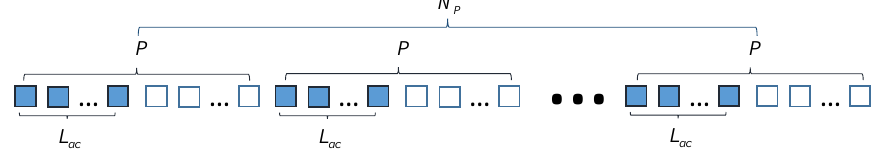
Figure 4. Periodic sparse model of CMUT linear array.